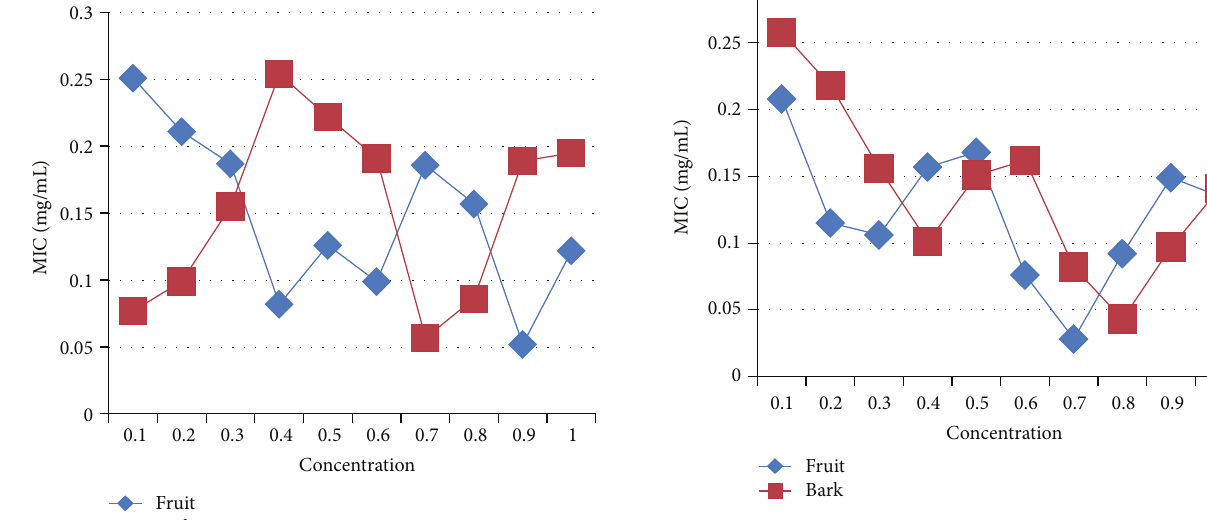
Figure 11: MIC values (mg/mL) exhibiting potential of bark and fruit of C. ambrosioides against P. aeruginosa